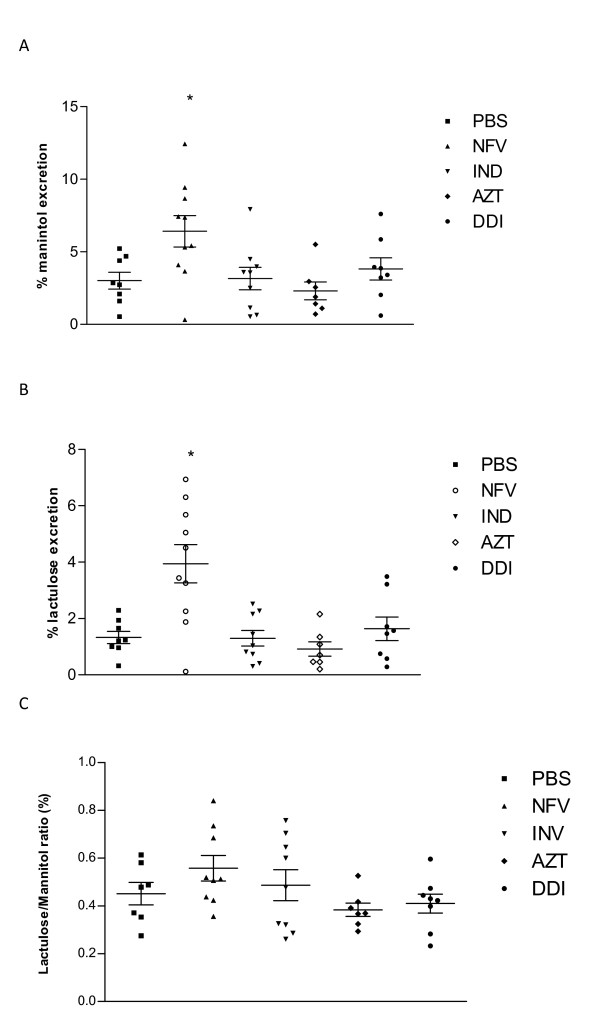
Lactulose and mannitol excretion (%) in experimental mice (n = at least7 per group) following 7 days of treatment with either nelfinavir (NFV, 100 mg/kg), indinavir (IDV, 100 mg/kg), zidovudine (AZT, 50 mg/kg) and didanosine (DDI, 100 mg/kg) or PBS. *statistical significance (P < 0:05) compared to the PBS control group by ANOVA and Bonferroni's multiple test.